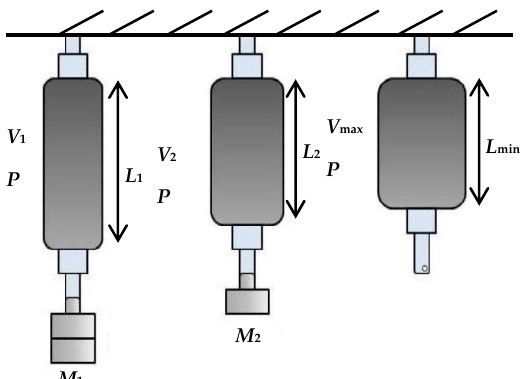
Figure 4. Isobaric characteristic of the pneumatic muscle actuator.